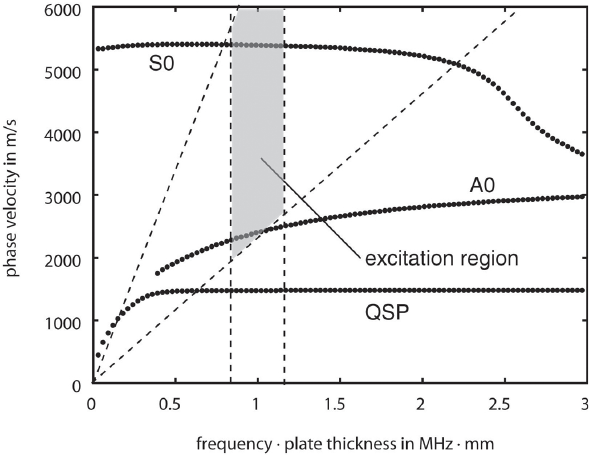
Figure 3. Dispersion diagram of a glass plate in contact with a liquid half-space together with the excitation line and the excita- tion region of the single-phase transducer. (glass: v l = 5654ms − 1 , v s = 3391ms − 1 , ρ = 2550kgm − 3 ; water: v l = 1480ms − 1 , v s = 0 . 0001ms − 1 , ρ = 1000kgm − 3